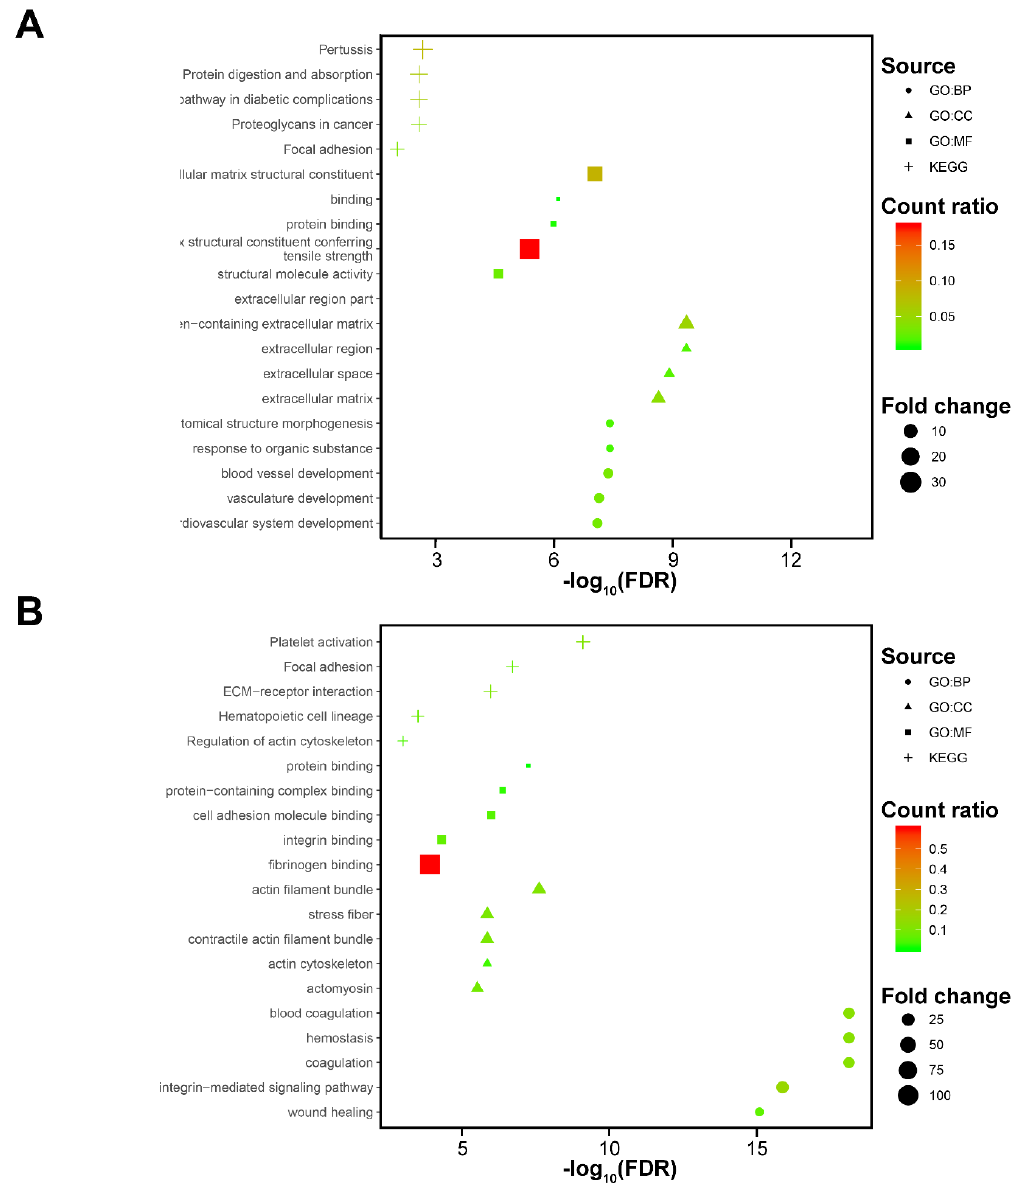
Figure 3. Functional enrichment analysis of cluster-specific markers. Functional enrichment analysis of genes in the clusters 1 ( A ) and 3 ( B ), top five enriched Kyoto Encyclopedia of Genes and Genomes (KEGG) pathways, Gene Ontology (GO) terms for biological processes (BP), cell components (CC) and molecular functions (MF) [fold enriched > 2 and false discovery rate (FDR) < 0.001]. BP, biological process; CC, cellular component; FDR, false discovery rate; KEGG, Kyoto Encyclopedia of Genes and Genomes; MF, molecular function; GO, gene ontology.